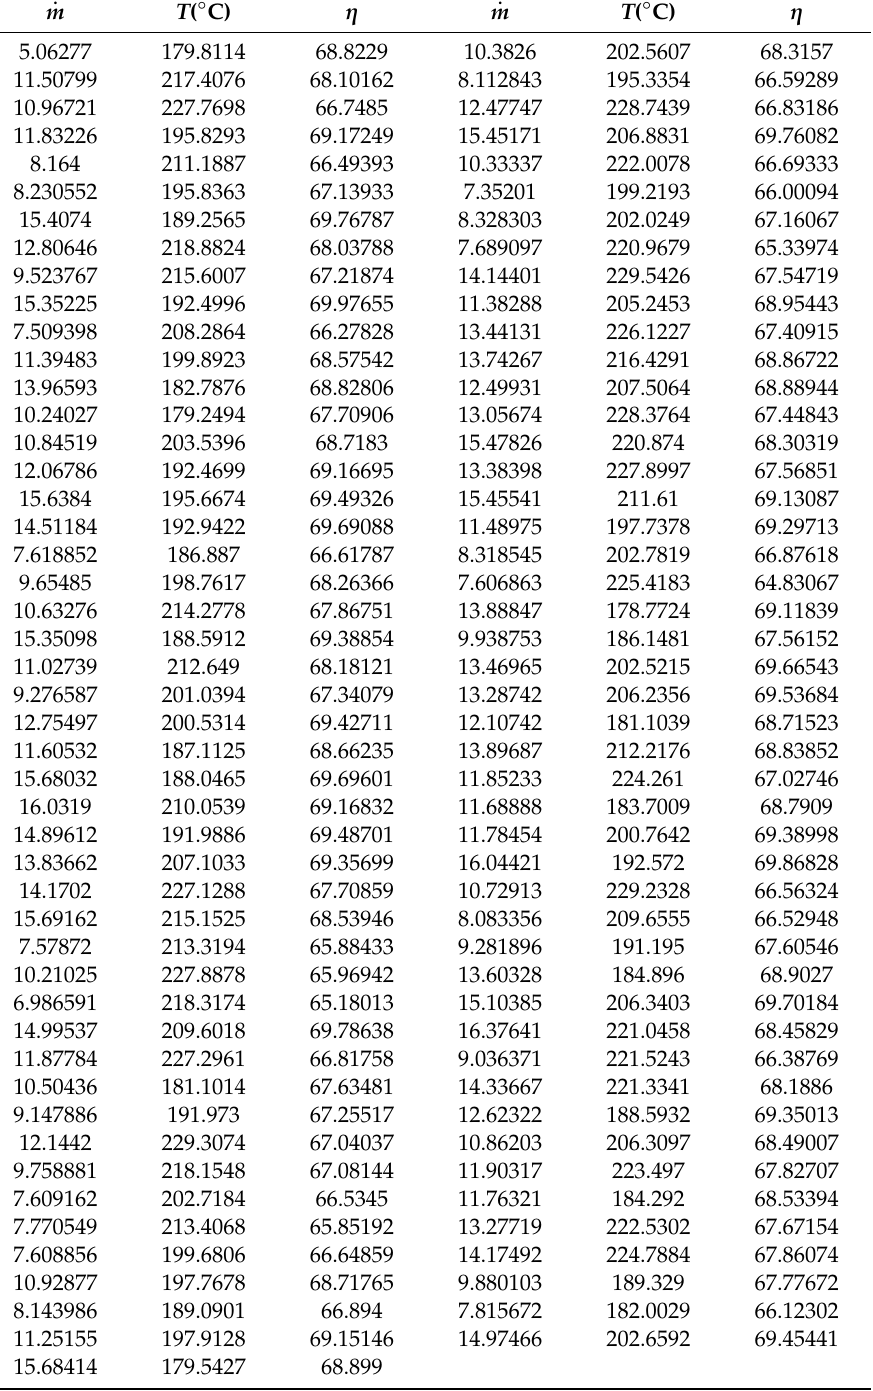
Table 1. The experimental data used to form the neural network